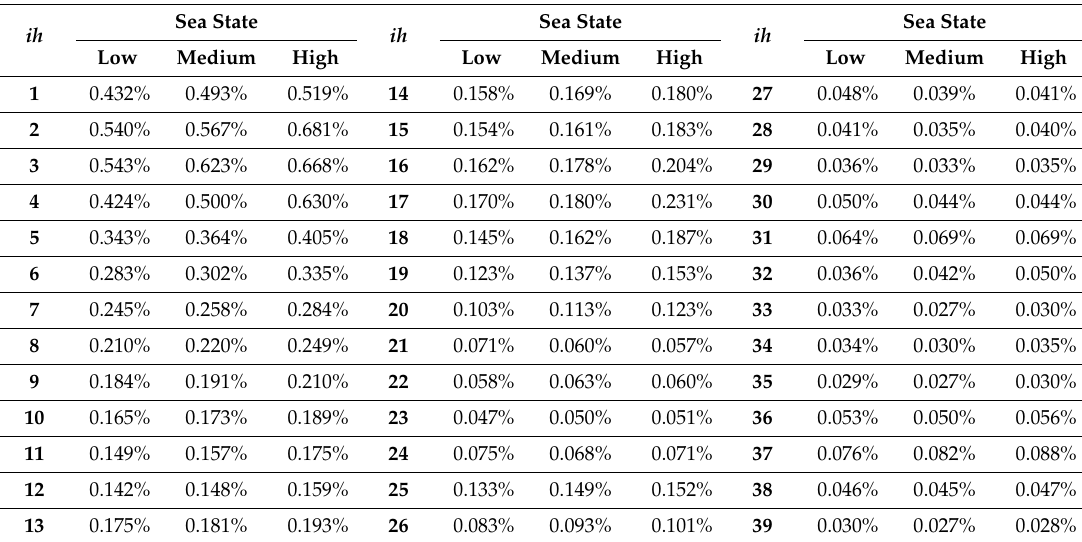
Table 5. Laboratory trials average reportable ratios of harmonic current amplitudes for each resource classification.